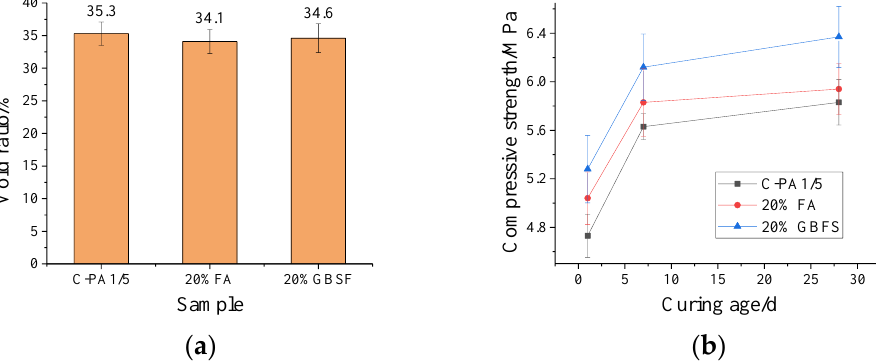
Figure 8. Effect of mineral admixture on ( a ) void ratio and ( b ) compressive strength of porous ecological concrete.